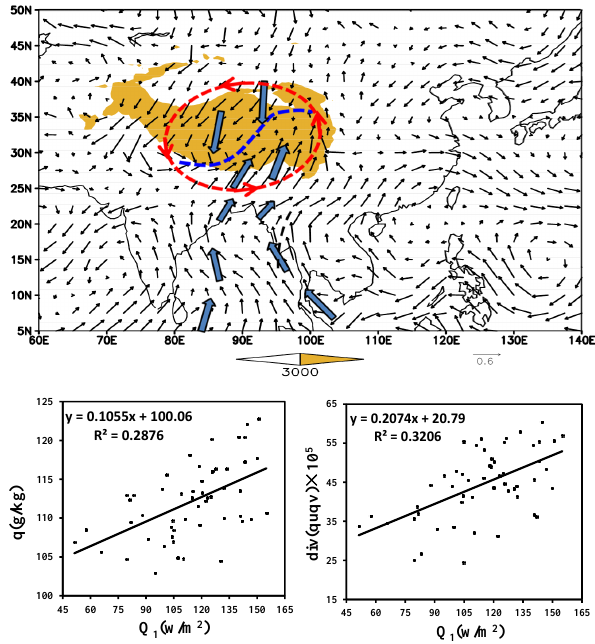
Figure 4. Correlation vectors of the TP heat source column strength Q 1 to the horizontal moisture transport flux components over sum- mer of 1957–2009. A shear line between southward and northward air flows (light blue arrows) and the plateau low vortex over the TP are marked with blue and red dash lines, respectively. The TP region with the altitude of higher than 3000m is shaded in yellow contour (upper panel). Correlations of the heat source strength Q 1 , total wa- ter vapor q and net vapor transport flux divergence (div) in the TP air column in summer of 2000–2009 in scatter plots of Q 1 to q (left lower panel) and div (right lower